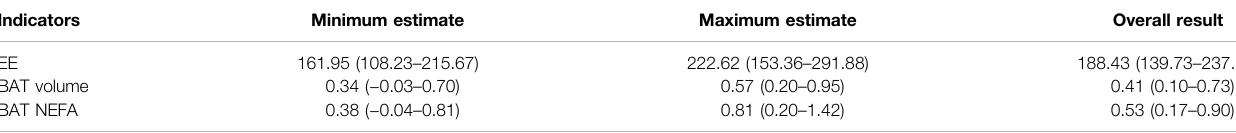
TABLE 2 | The pooled results of sensitivity analyses, (95% CI).